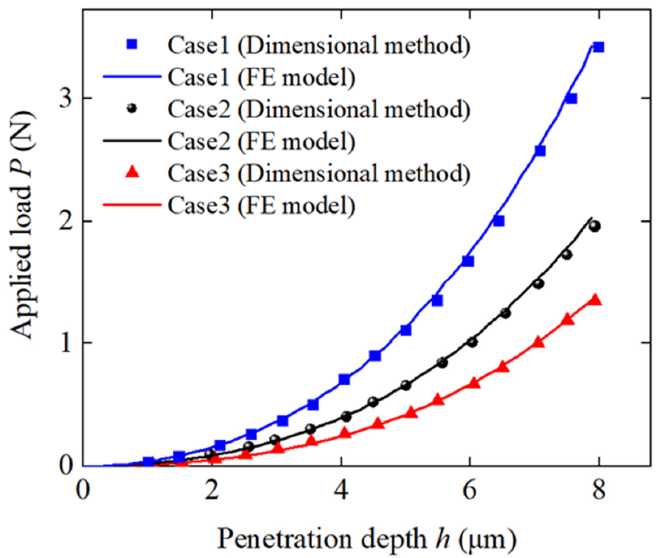
Figure 12. Prediction comparisons by the proposed dimensional method and the established FE model for three new randomly determined conditions.